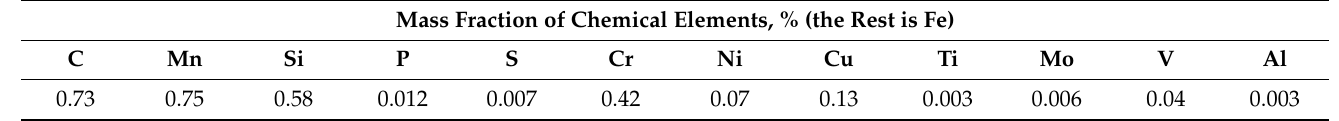
Table 1. Chemical composition of DT 350 category rails. Mass Fraction of Chemical Elements, % (the Rest is